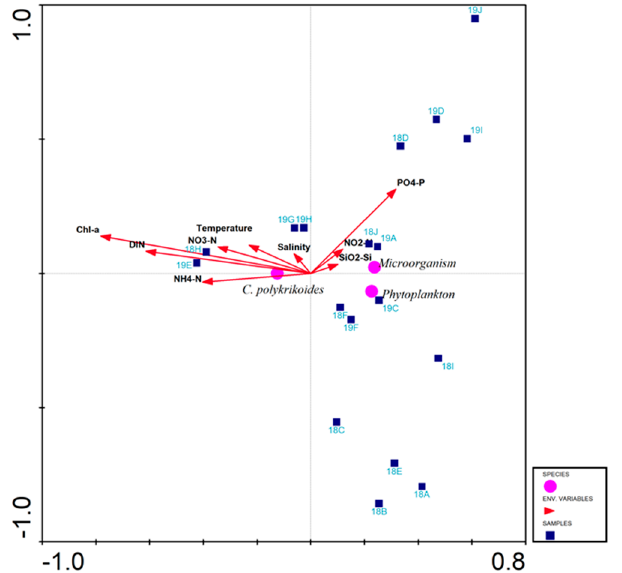
Figure 8. Canonical correspondence analysis (CCA) of microbial communities (OTUs), phytoplankton communities, and environmental parameters sampled during C. polykrikoides bloom .